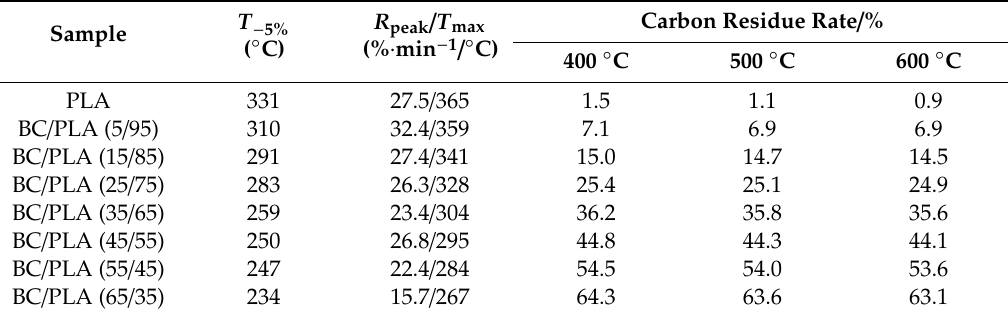
Table 3. TG test data of PLA and BC / PLA materials under N 2 atmosphere.